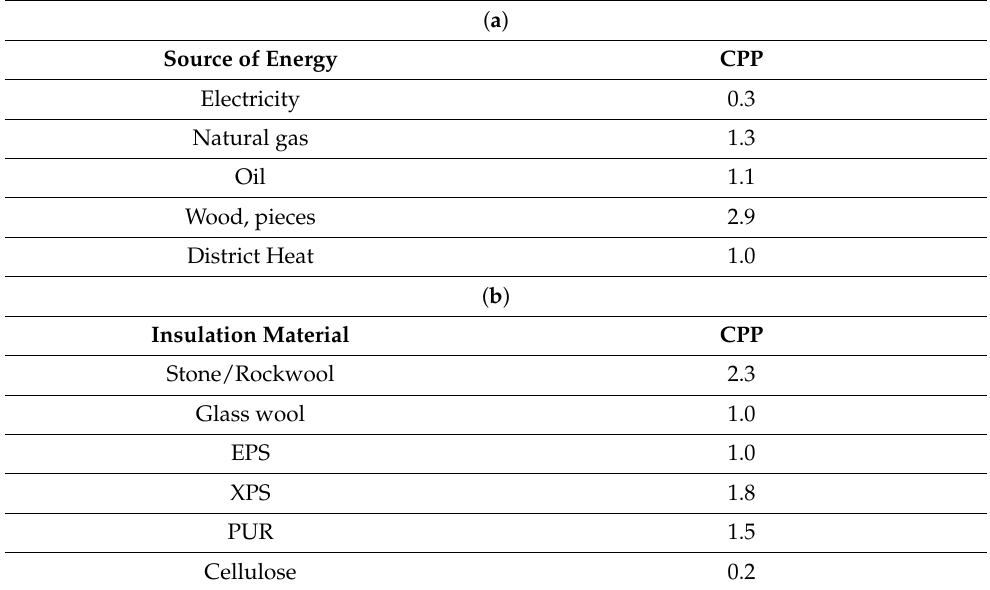
Table 6. ( a ) Average CPP values for different energy sources. ( b ) Average CPP values for various insulation